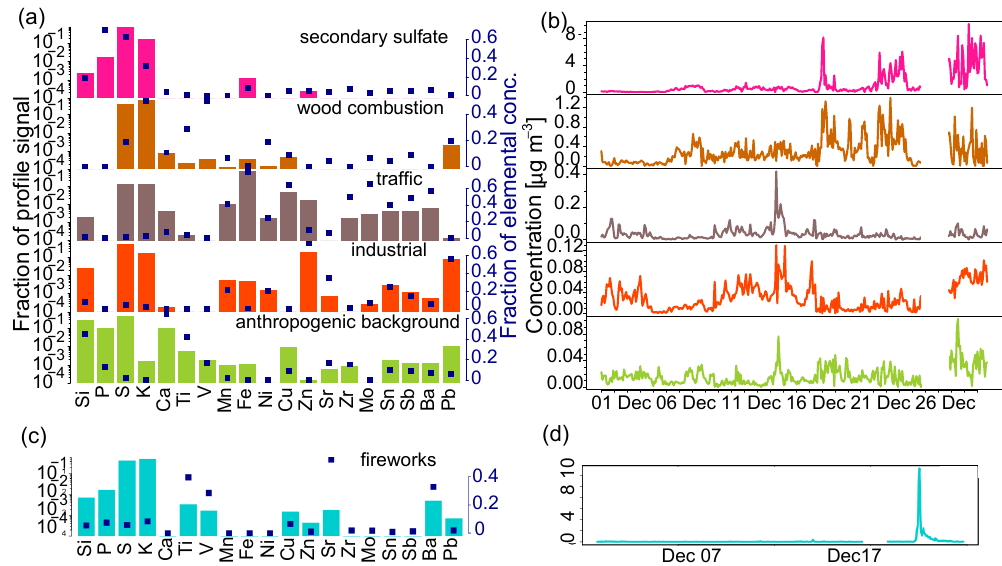
Fig. 4. PMF results for PM 1 − 0 . 1 . (a) factor profiles, from top to bottom: secondary sulfate, wood combustion, road traffic, industrial and local anthropogenic background. The solid bars (left y -axis) represent the amount of each species apportioned to the factor and the blue squares (right y -axis) represent the fraction of the total of each species. (b) corresponding time series. ( c and d ) profile and time series of the fireworks factor (full data set, including NYE data).